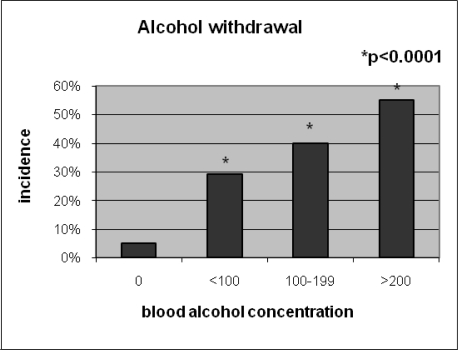
Incidence of alcohol withdrawal syndrome as BAC increases.